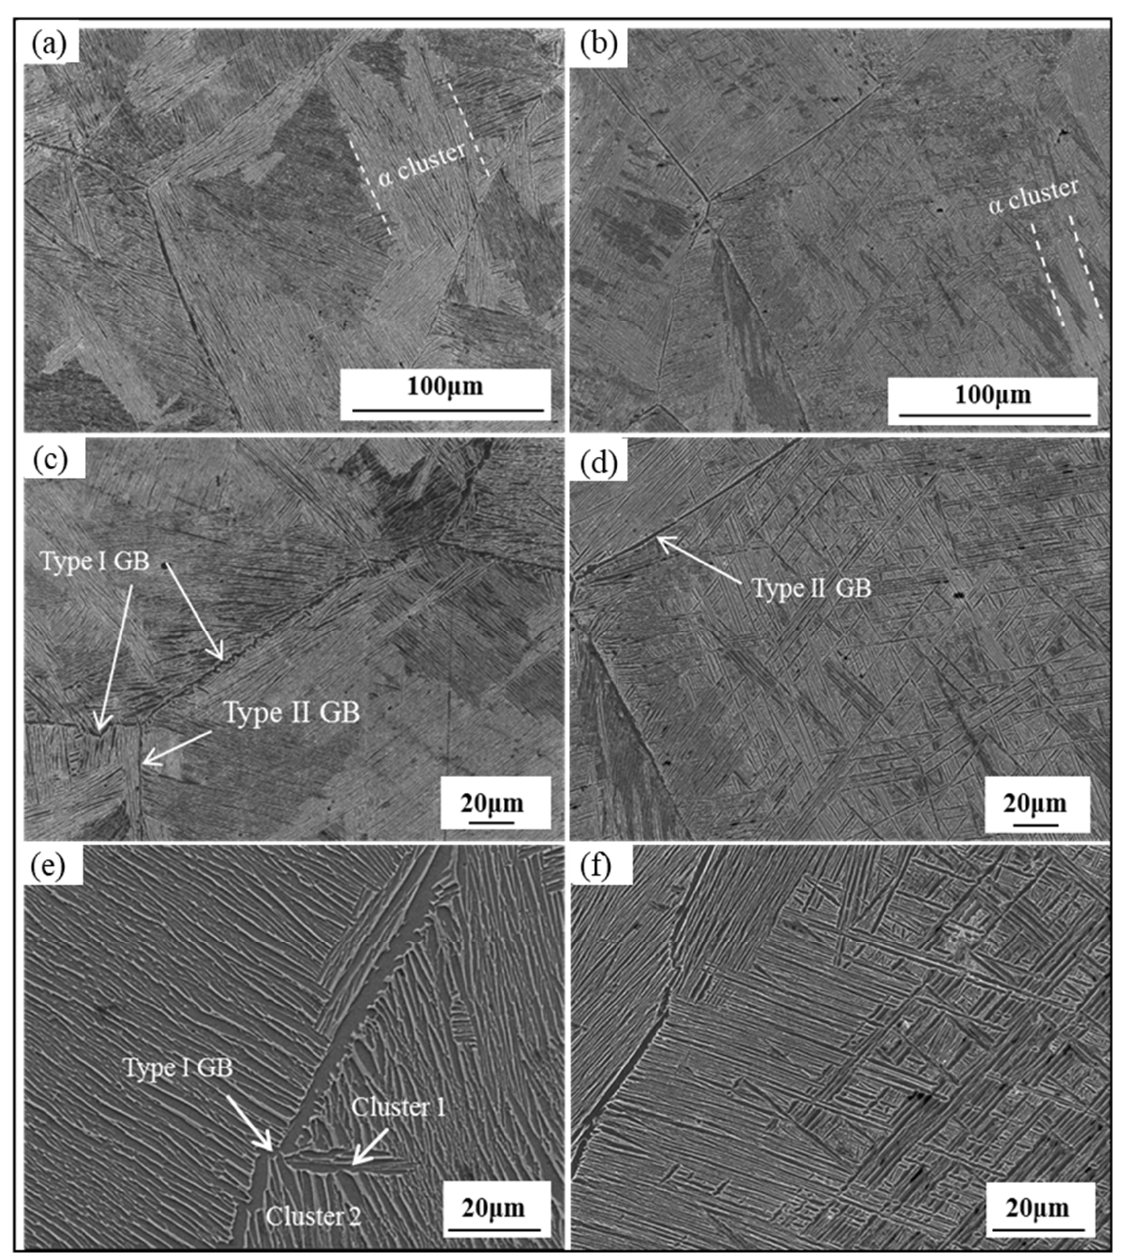
Figure 3. Microstructure of FC ( a , c , e ) and OFC ( b , d , f ).